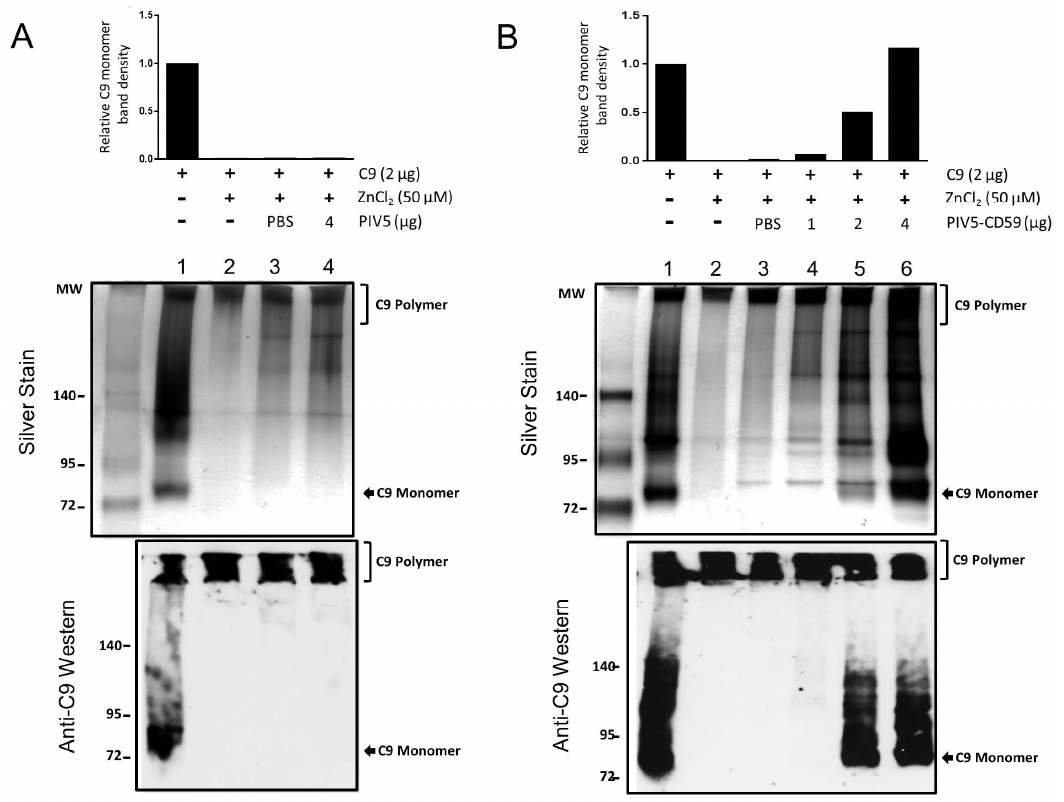
Figure 3. Effect of PIV5-associated CD59 on C9 polymerization in vitro. Purified C9 was incubated alone or with the indicated amounts of PIV5 ( A ) or PIV5-CD59 ( B ) at 37 °C for 40 min. Polymerization of C9 was initiated by adding ZnCl 2 to 50 μM and by further incubation for 2 h at 37 °C. Samples were separated through 4% to 20% gradient polyacrylamide gels under non-reducing conditions and C9 polymerization was visualized by silver staining (upper panel) or by Western blotting using the anti- C5b-9 antibody (lower panel). The C9 monomer band intensity was measured by Image J, which is shown in the upper panel. These results are an example of three independent experiments.